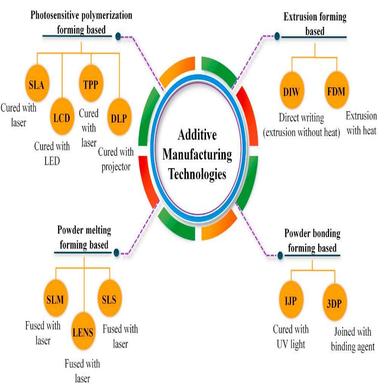
Classification of ceramic additive manufacturing technologies.